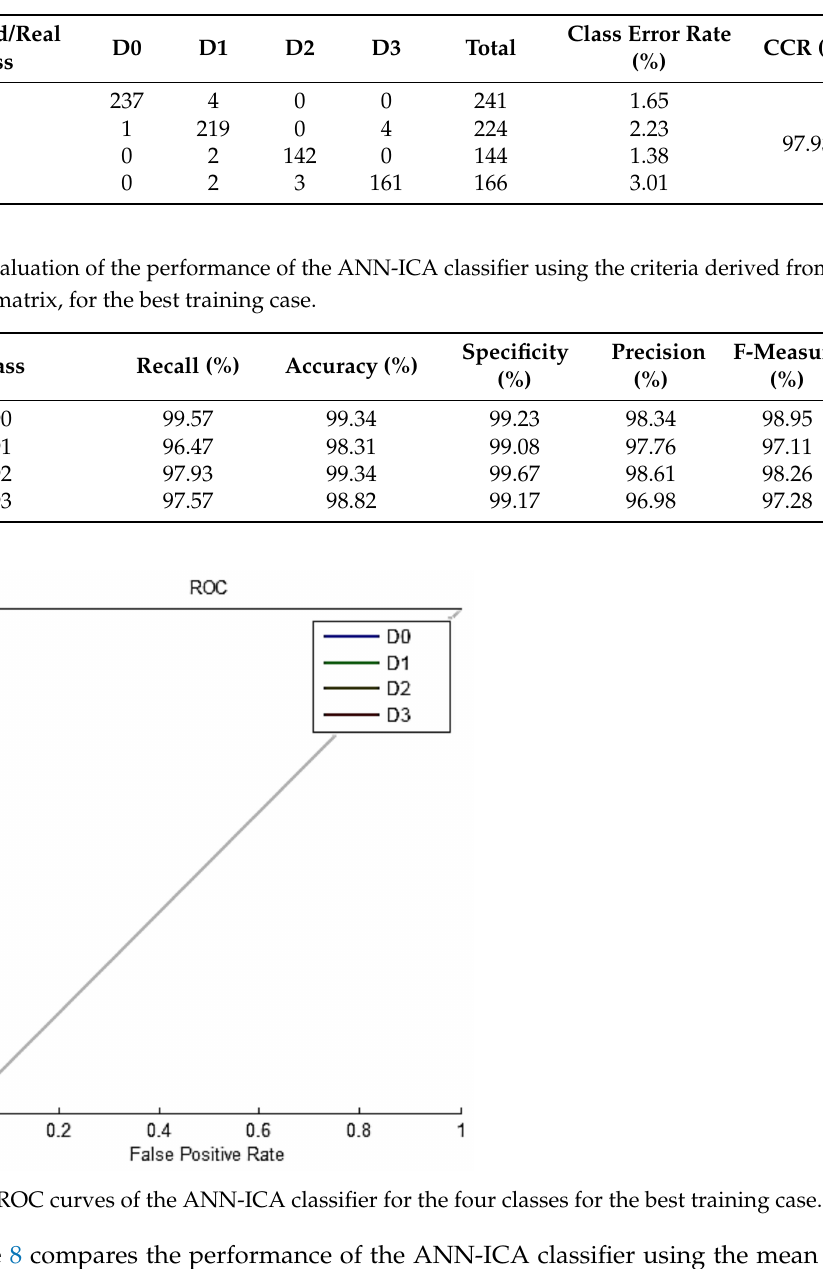
Table 6. Evaluation of the performance of the ANN-ICA classifier for the best training case.